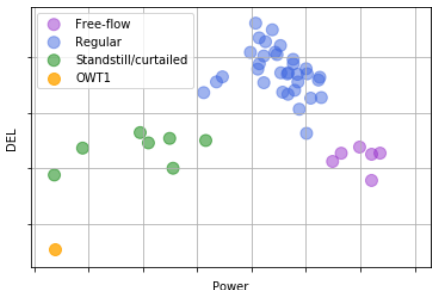
Figure 17. DEL (scenario F) vs. power plotted for the mean values of every turbine of the farm. The lowest DEL turbine – OWT 1 – is